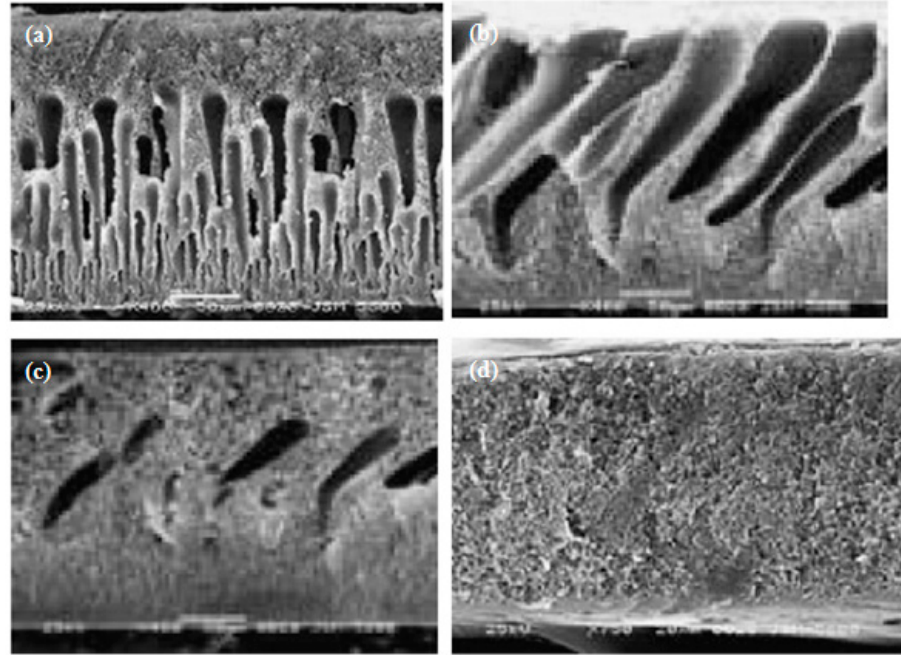
Figure 6. SEM (nanoscale) images of the morphology of PS/TiO 2 membranes with ( a ) 0 wt% TiO 2 ; ( b ) 1 wt% TiO 2 ; ( c ) 3 wt% TiO 2 and ( d ) 5 wt% TiO 2 . Reproduced with permission from Reference [73]. Copyright 2013